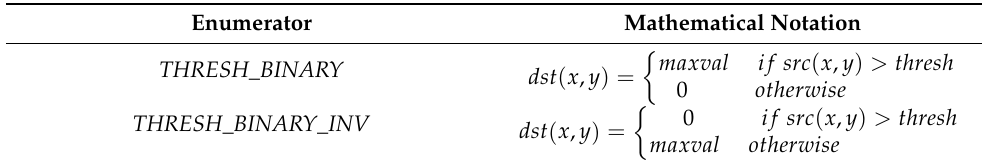
Table 1. Mathematical notations for the two types of thresholding.